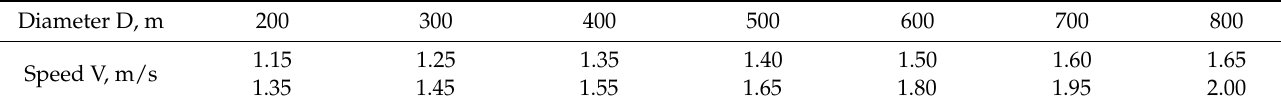
Table 2. Transportation rates of coal–water suspensions